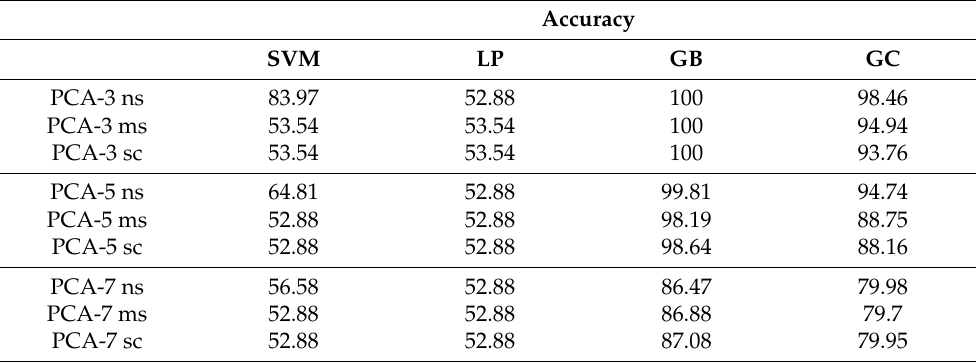
Table 3. The classification accuracy for HSI2 image 2 using PCA 3, 5, and 7 bands and the different scaling and normalization methods using the four machines for a 1500 pixels batch